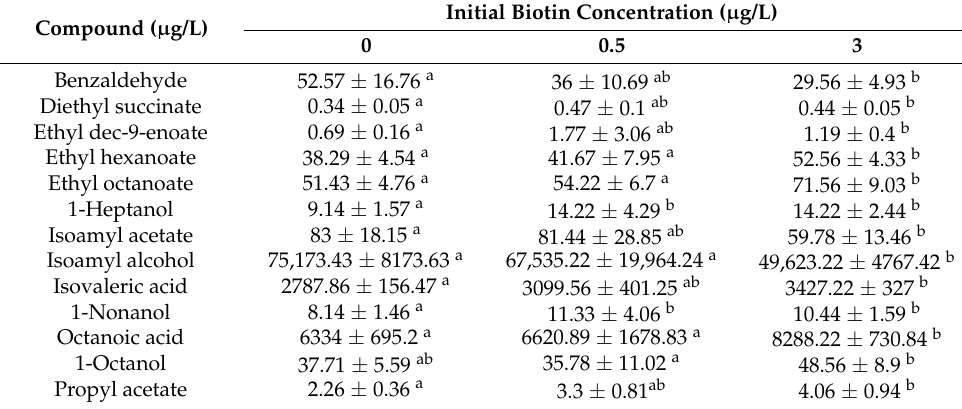
Figure 2. Hierarchical clustering of the biotin ( left ) and thiamine ( right ) significantly impacted volatile compounds in the final wines: effect of both vitamins on their profiles. ( A – C ): Biotin- impacted volatile compounds (( A ): Fatty acid metabolites, ( B ): Ehrlich pathway metabolites, ( C ): Central carbon metabolites). ( D – F ): Biotin-impacted volatile compounds (( D ): Fatty acid metabo- lites, ( E ): Ehrlich pathway metabolites, ( F ): Central carbon metabolites). Table 6. Biotin-dependent volatile contents in the final